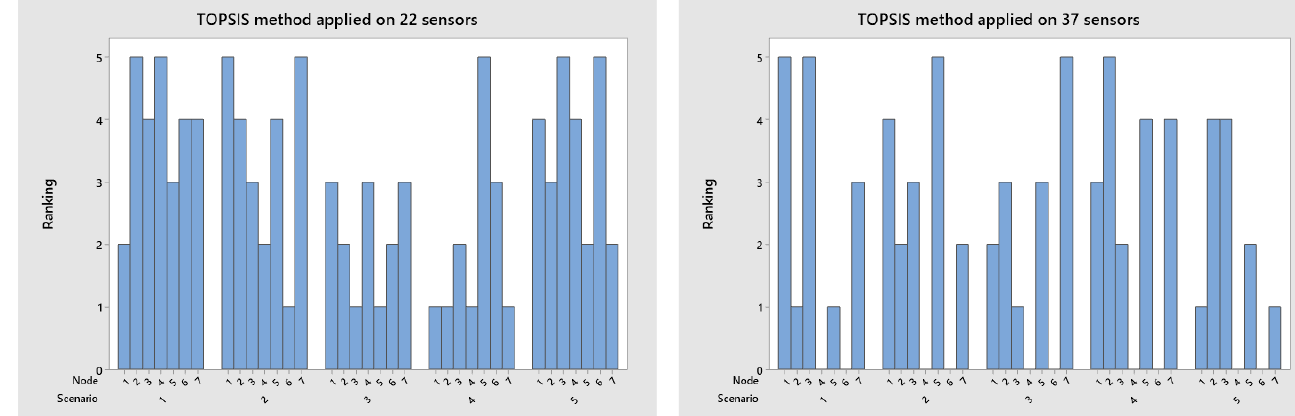
Figure 7. Rank applied TOPSIS algorithm for the network with 22 and 37